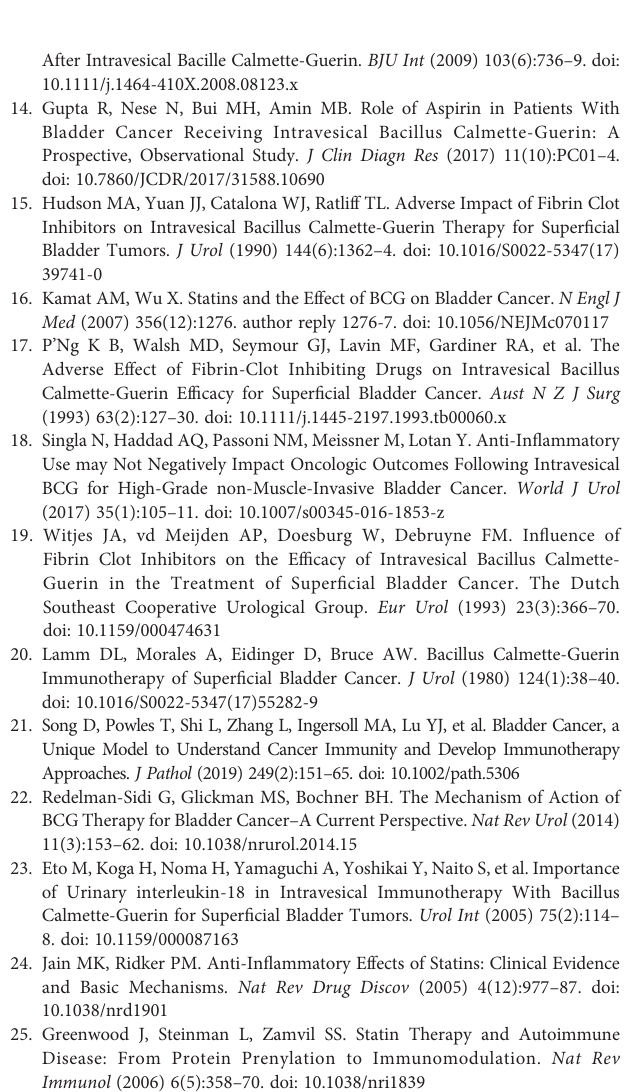
Supplementary Figure 1 | Sensitivity analysis for dichotomous variable: (A) Recurrence in statins, (B) recurrence in fi brin clot inhibitors, (C) progression in statins, (D) progression in fi brin clot inhibitors. Supplementary Figure 2 | Sensitivity analysis for survival variable: (A) RFS in statins, (B) RFS in fi brin clot inhibitors, (C) PFS in statins, (D) PFS in fi brin clot inhibitors, (E) CSS, (F) OS. Supplementary Figure 3 | Funnel plot for dichotomous variable: (A) Recurrence in statins, (B) recurrence in fi brin clot inhibitors, (C) progression in statins, (D) progression in fi brin clot inhibitors. Supplementary Figure 4 | Funnel plot for survival variable: (A) RFS in statins, (B) RFS in fi brin clot inhibitors, (C) PFS in statins, (D) PFS in fi brin clot inhibitors, (E) CSS, (F)